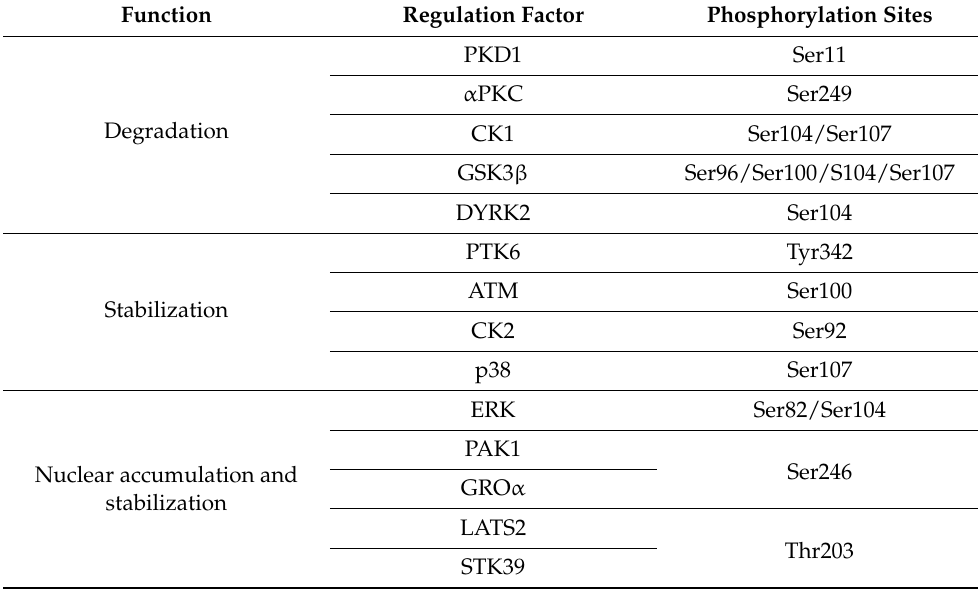
Table 1. Phosphorylation regulators involved in